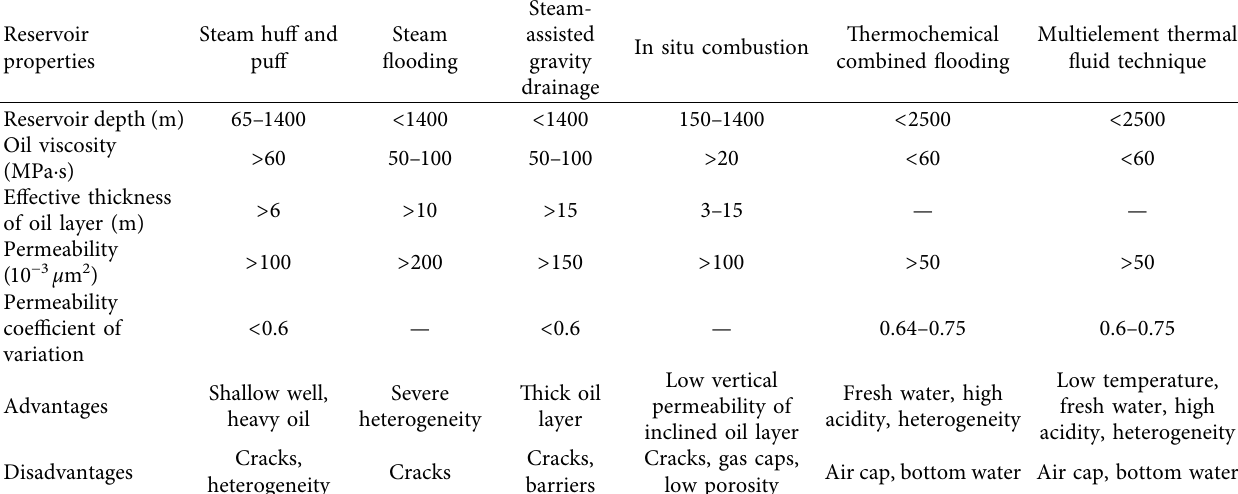
Table 1: Production characteristics and reservoir adaptability of the different heavy oil thermal recovery techniques.